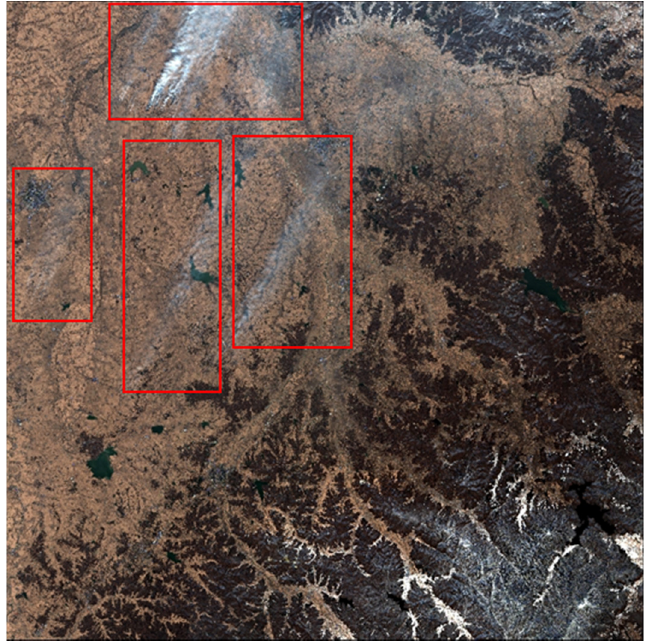
Figure 3. The 4 − 3 − 2 band composite image. Figure 3. The 4-3-2 band composite